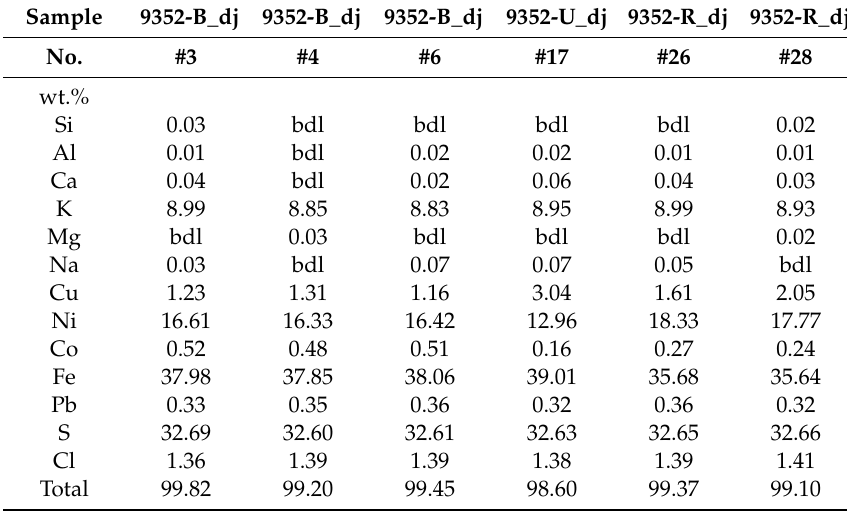
Figure 7. Diagrams showing the composition of djerfisherite. ( a ) Ni vs. Fe and ( b ) Ni vs. Cu plots; 1, djerfisherite from the groundmass of the site 73 Menominee kimberlite (this work); 2, djerfisherite from kimberlite groundmass and from melt inclusions in kimberlitic olivine from the Udachnaya- East pipe [28,29]; 3, djerfisherite from xenoliths from the Siberian kimberlites [29–34]; 4, djerfisherite from sulfide inclusions in the Siberian diamonds [30,35].